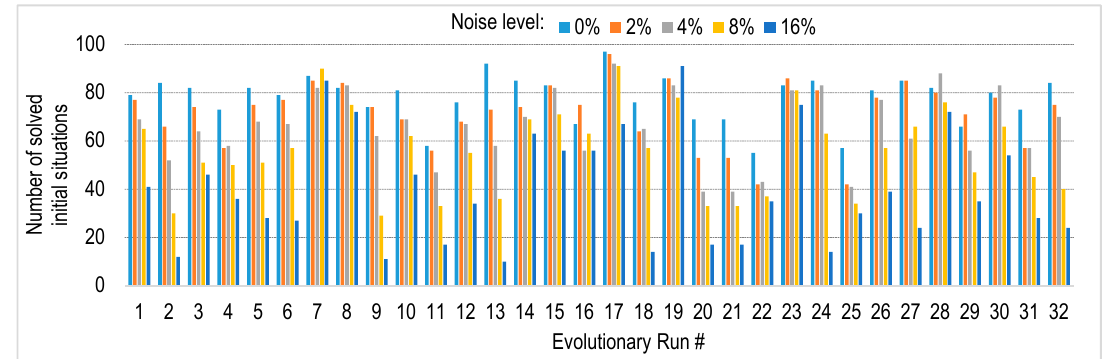
Figure 7. Number of successfully solved initial situations for various levels of FN perception noise.